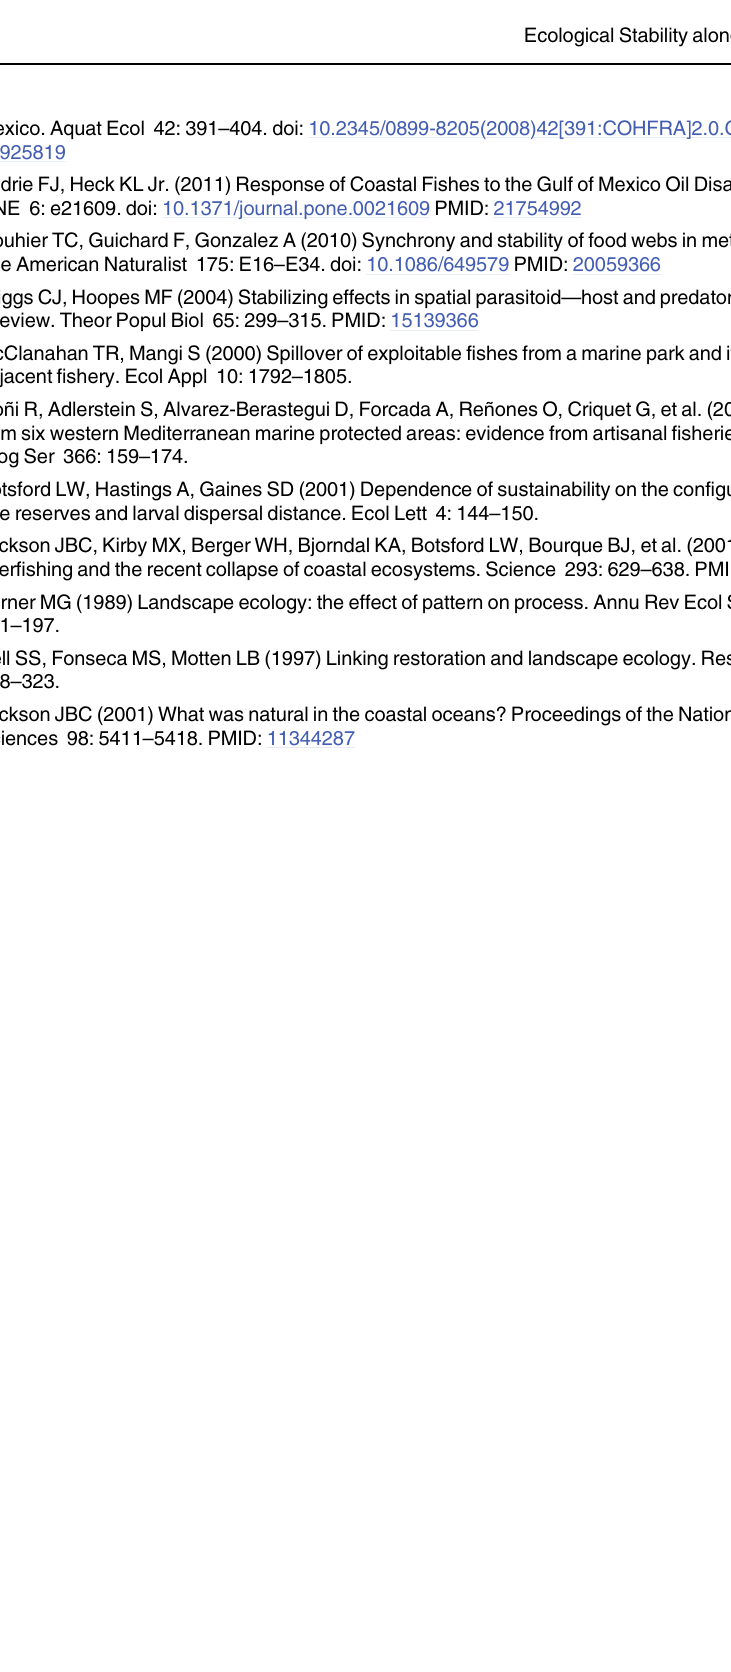
PLOS ONE | DOI:10.1371/journal.pone.0118580 June 3,